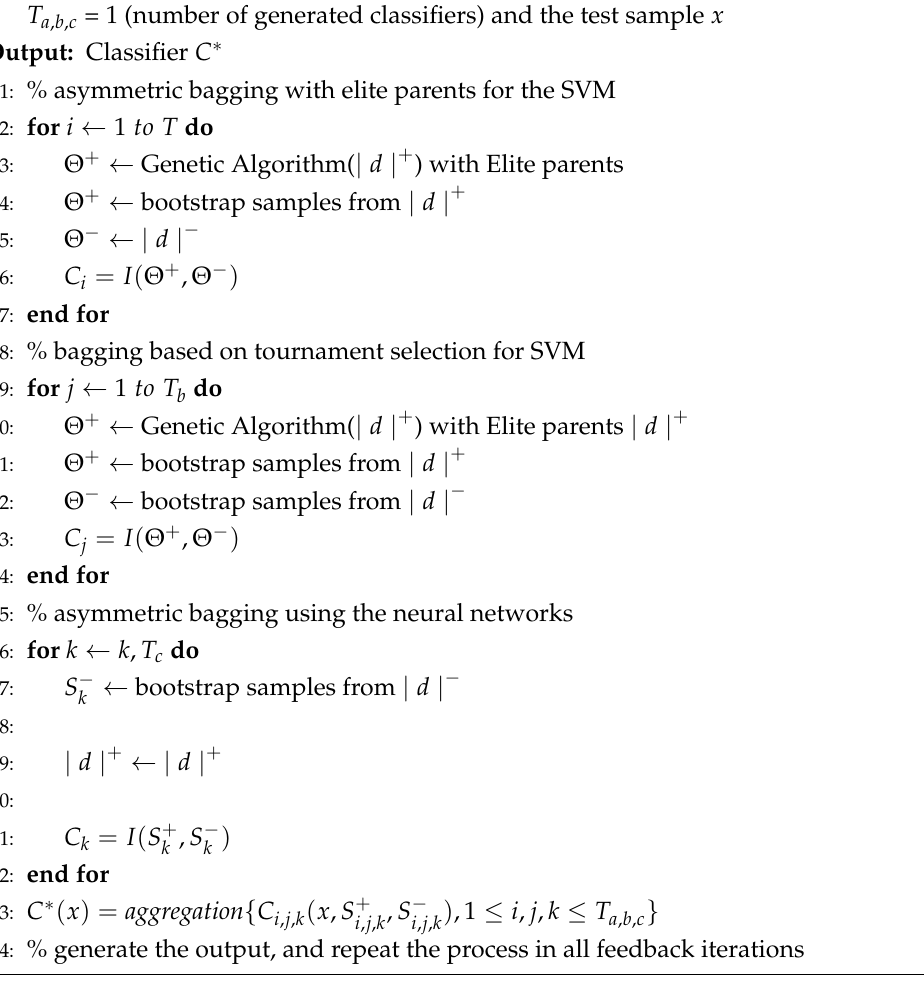
Algorithm 5 The relevance feedback